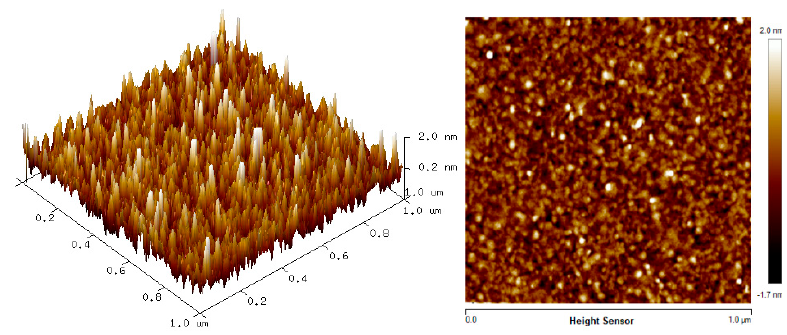
Figure 6. AFM images of HGQDs thin film.